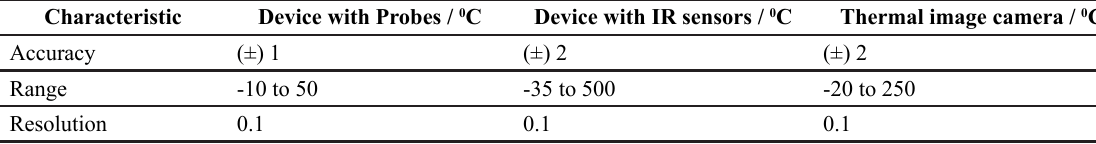
Table 2: Characteristics of temperature measurement devices.